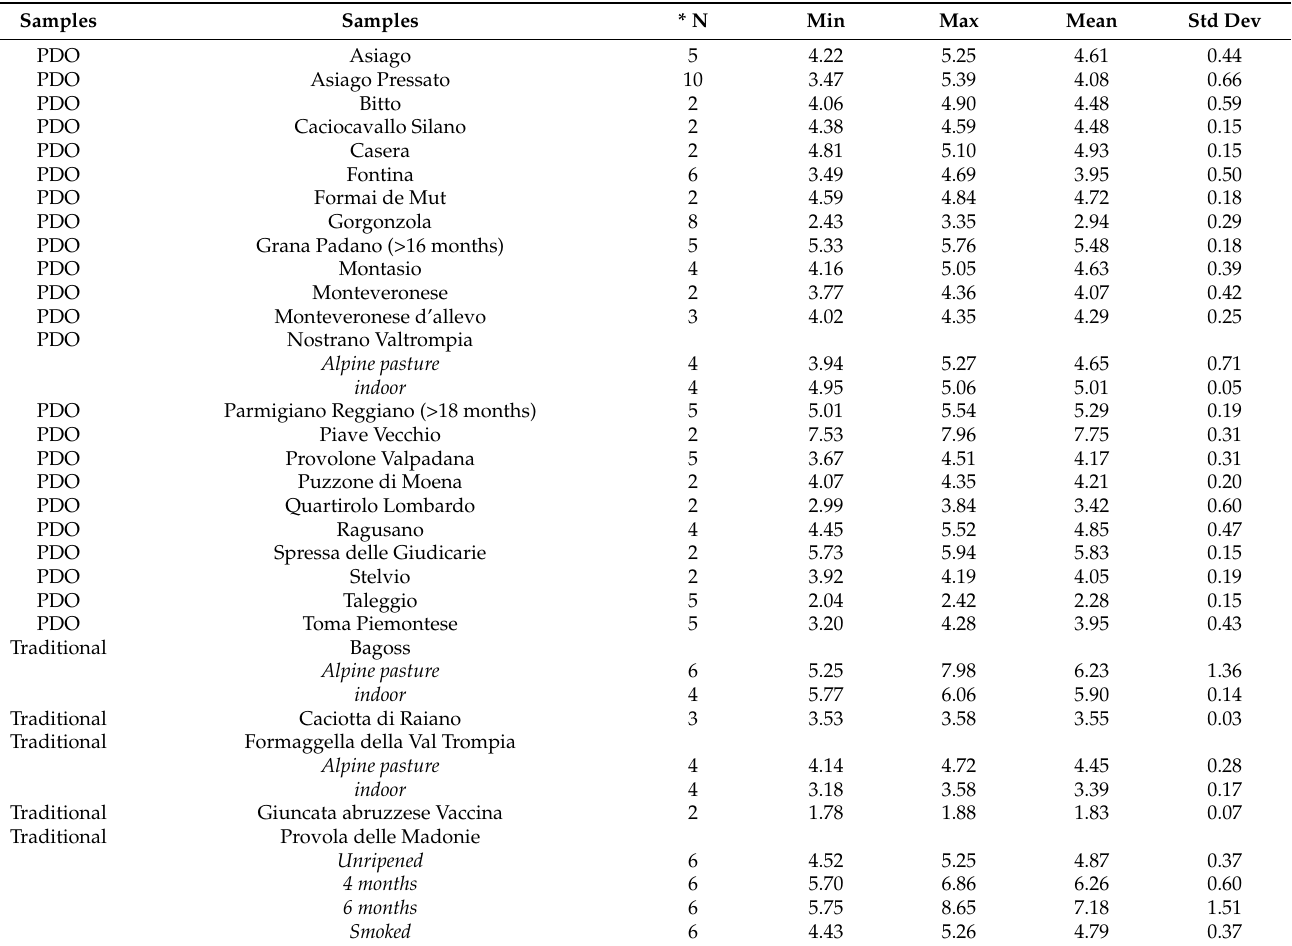
Table 1. Zinc content in PDO and Traditional Italian cow cheeses (mg/100 g). Samples